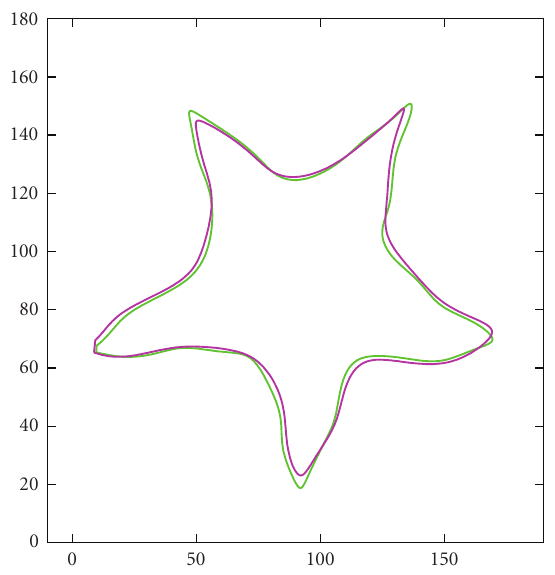
Figure 7: Recovery of the boundary of the star comparing the recovered boundary shown in Figure 4 to the recovered boundary shown in Figure 6. In this comparison, the recovery algorithm is implemented so that the smoothing is proportional to the noise in the cases being compared, yielding excellent results.